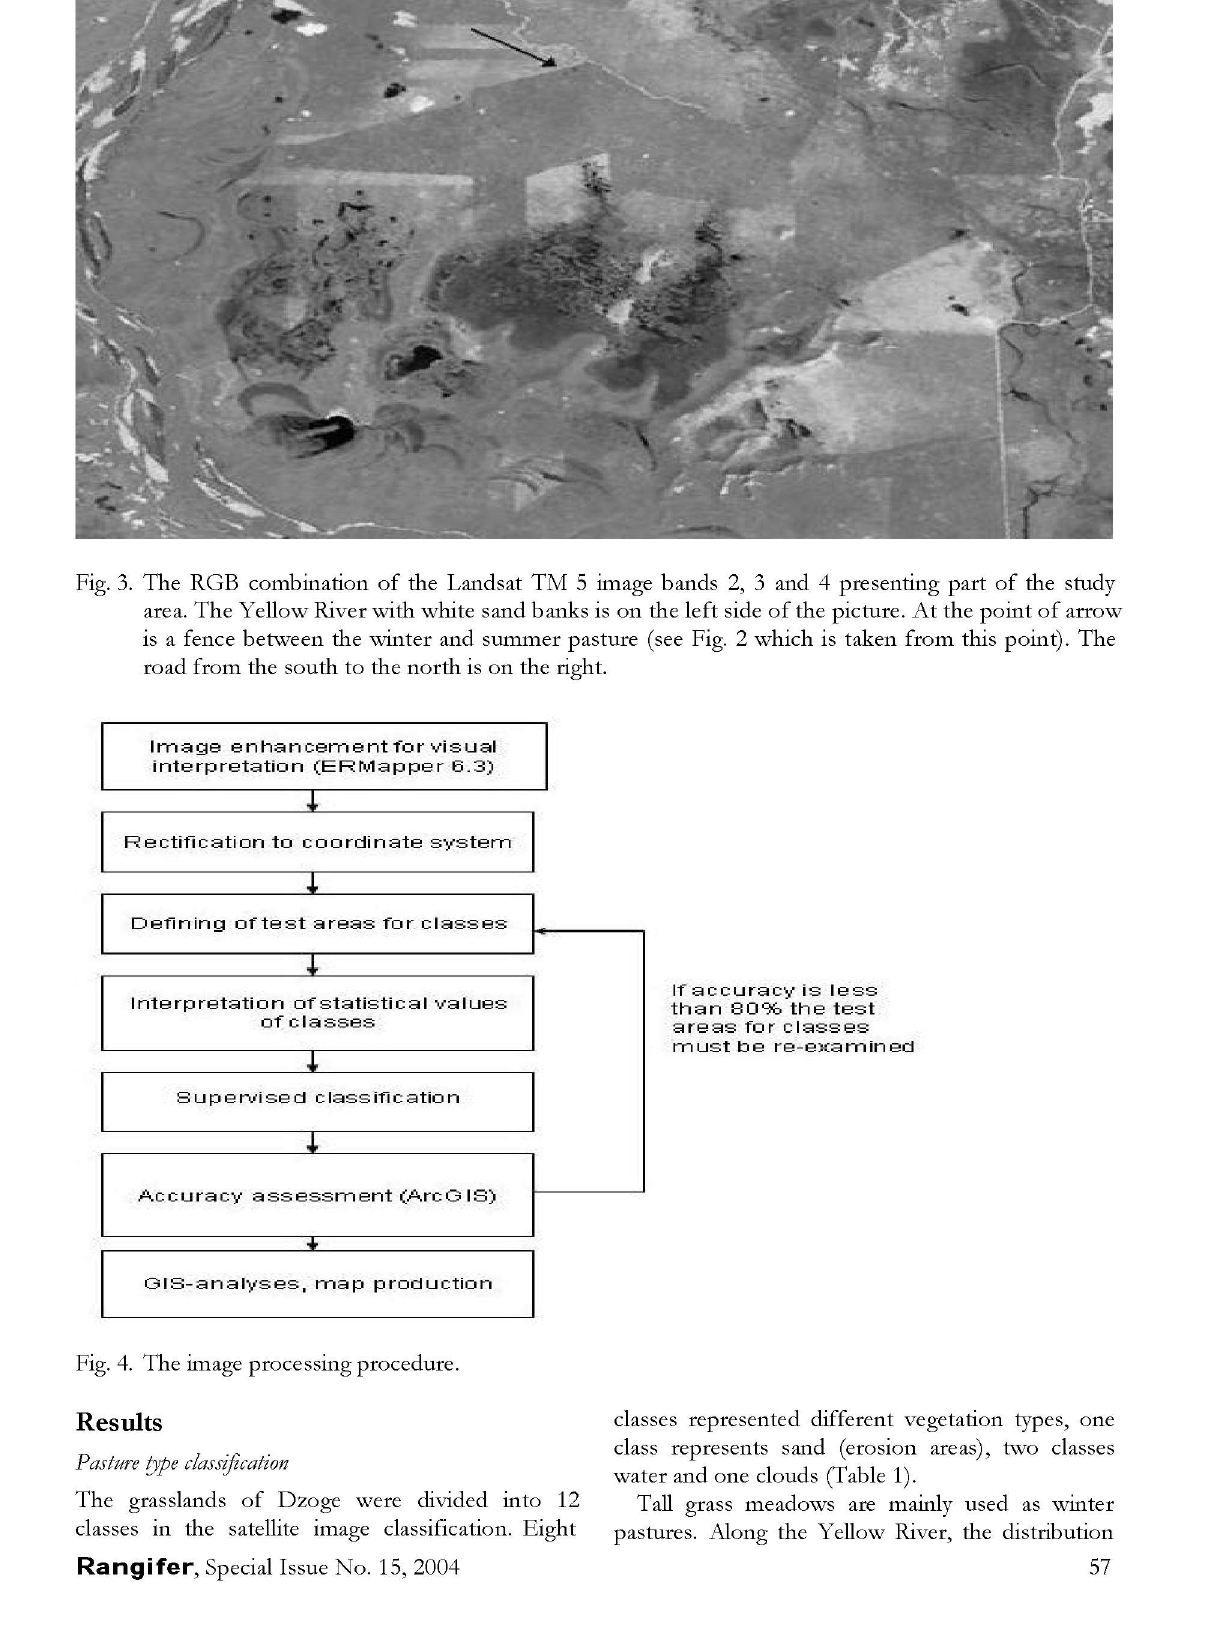
class represents sand (erosion areas), two classes water and one clouds (Table